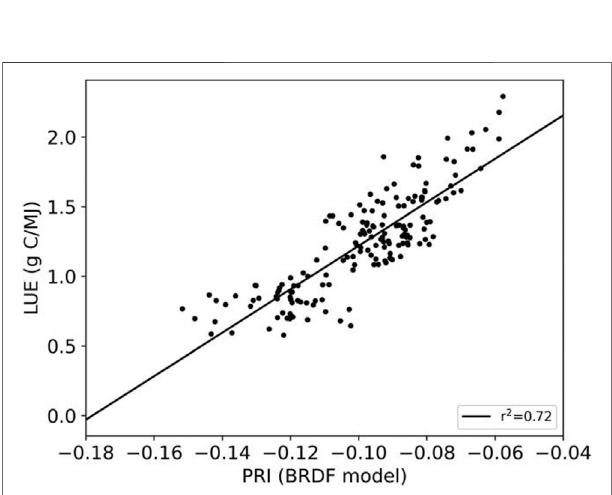
FIGURE 6 | Correlation comparison of PRI-LUE from different observation angles on clear days. (A – D) represent OZAs of 15 ° , 30 ° , 45 ° , and 60 ° , respectively.